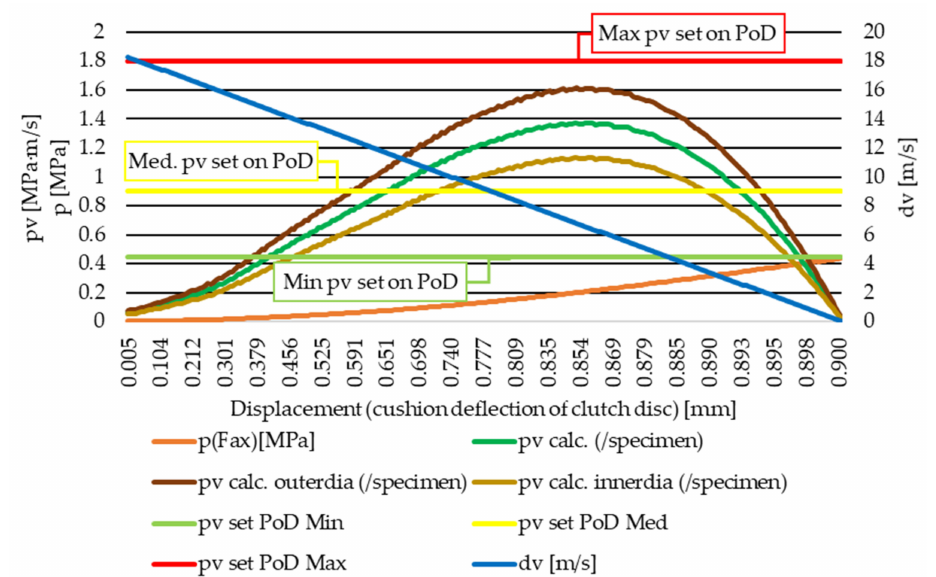
Figure 6. Example of calculated pv value change during clutch actuation along the facing deflection and the three set pv -values for pin-on-disc